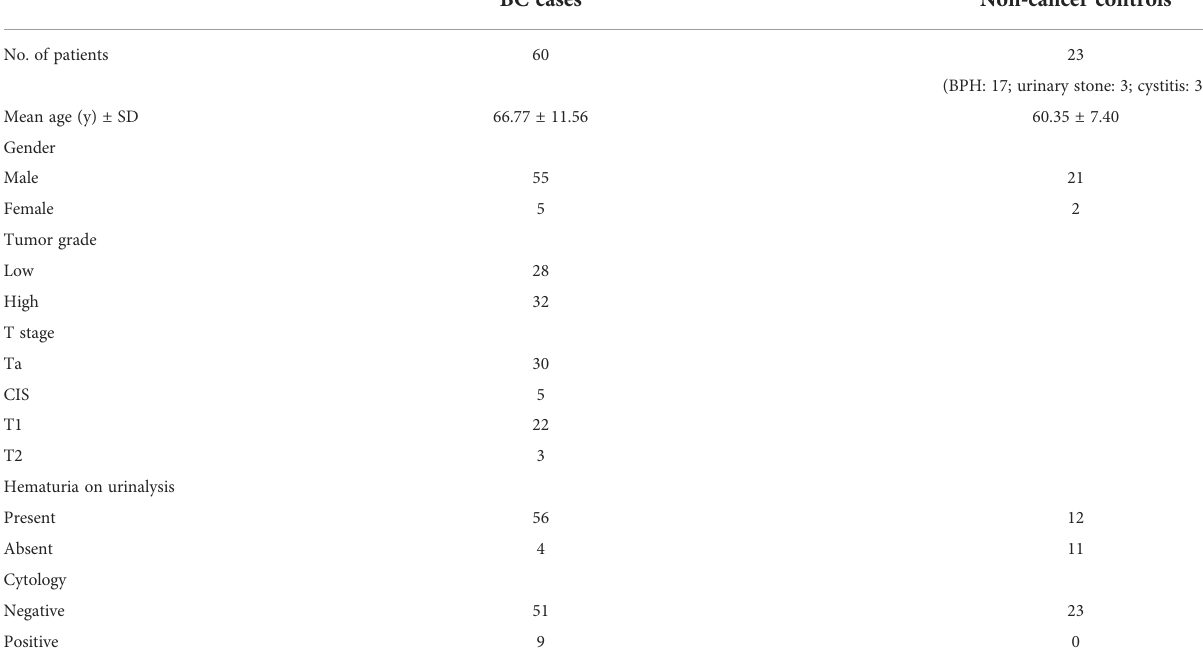
TABLE 2 Demographic characteristics of subjects for the analysis of a2M through ELISA.